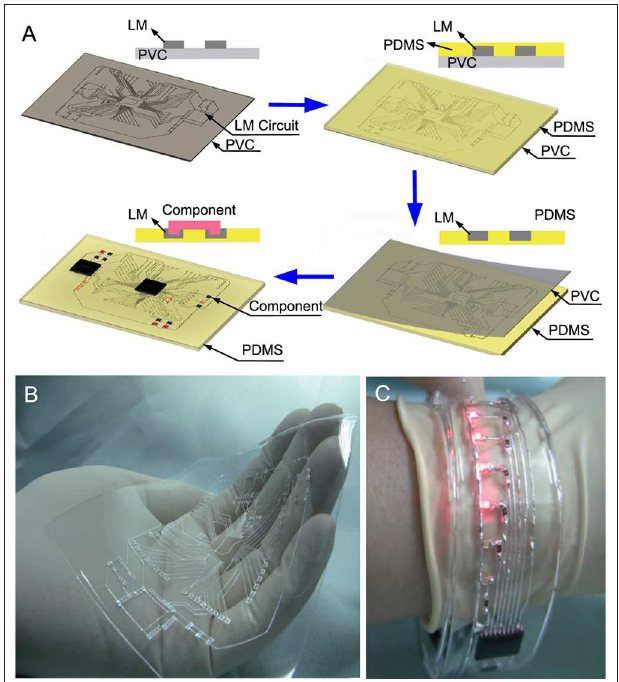
FIGURE 10 | Schematic diagram of liquid metal corrosion sculpture method (A) , and four different patterns printed on Al substrates with liquid metal corrosion sculpture method (B–E) . Reproduced with permissions from Lu et al. (2017). Copyright 2017, Science China Press and Springer Nature.